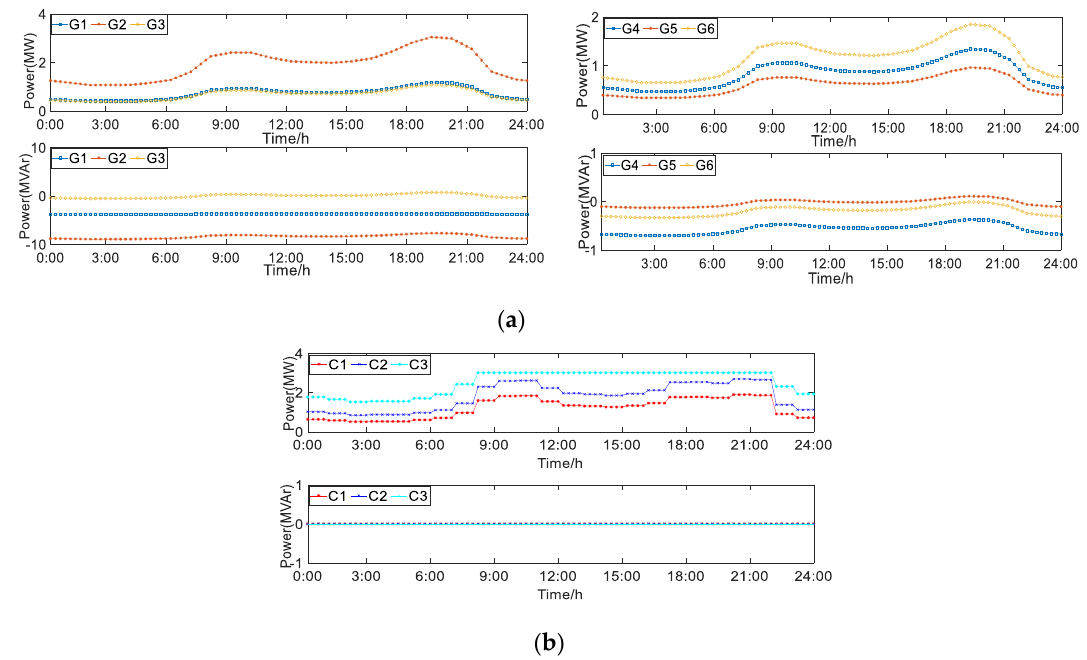
Figure 10. Optimized unit output of this method. ( a ) Active and reactive power output of thermal power units. ( b ) Active and reactive power output of the CHP unit.